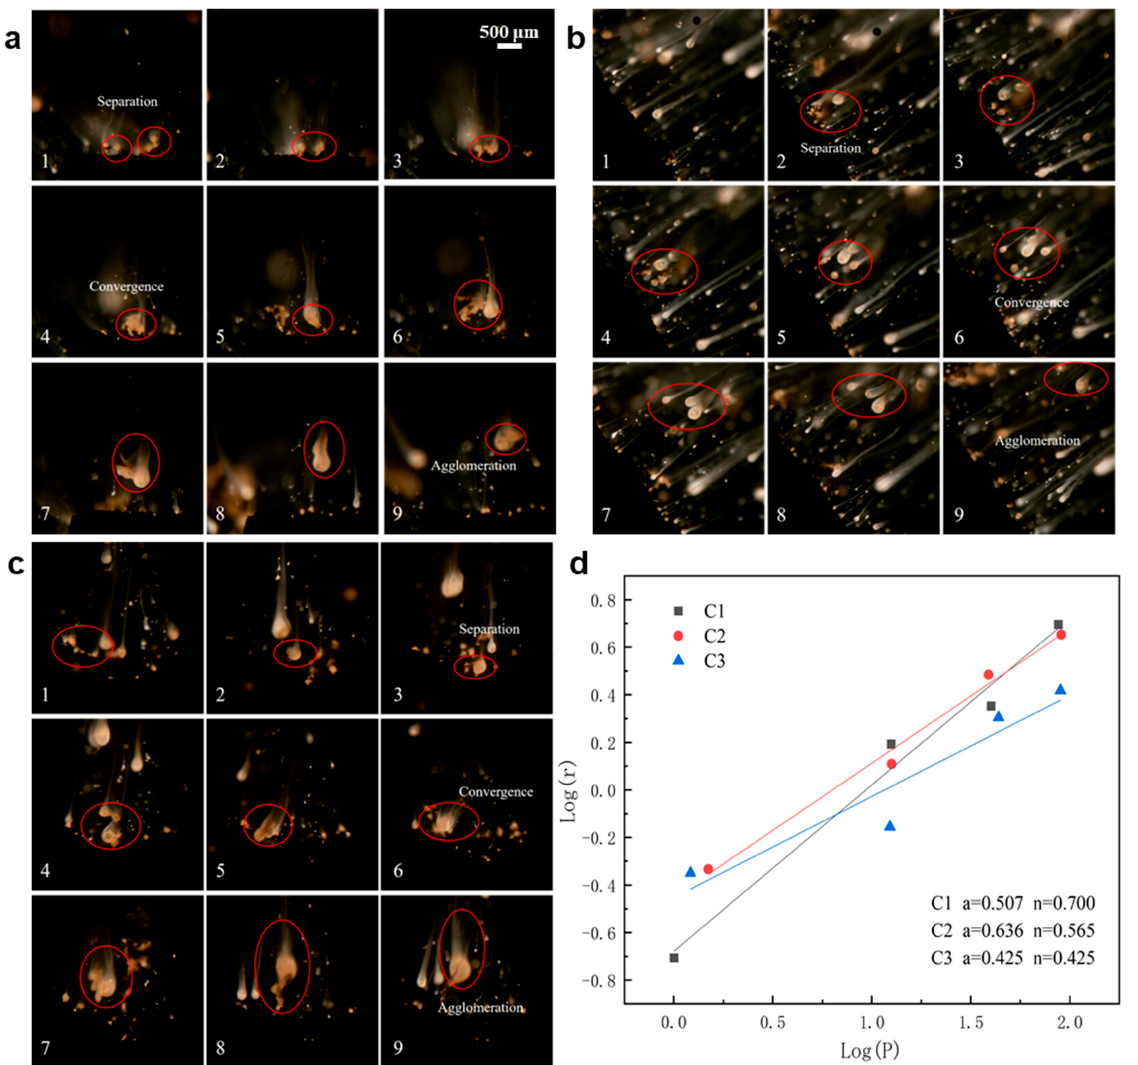
Figure 3. Surface agglomerates of three different samples: ( a ) C1 propellant, ( b ) C2 propellant, ( c ) C3 propellant, and ( d ) Processing and fitting of the combustion data of propellant samples: The fitted line connected by black and gray (squares) are C1 propellants, while red (circles) and blue (triangles) represent C2 and C3 propellants, respectively. The fitting equation is as follows: ln r = n ln P + ln a, where r is the burning rate (mm·s − 1 ), a is the burning rate coefficient, P is the combustor pressure (MPa), and n is the pressure exponent.